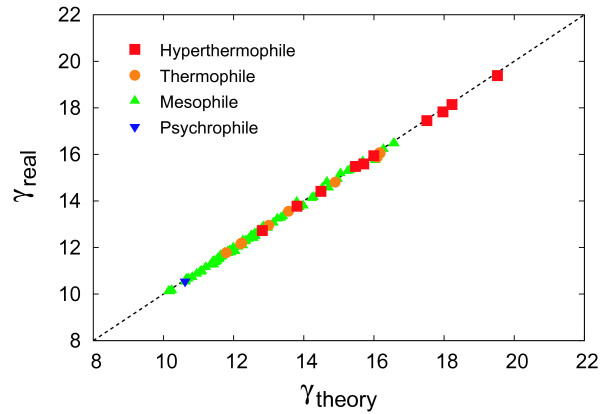
Comparison of the degree exponent γ between our model (theory) and real metabolic networks (real). The dashed line shows γreal = γtheory.